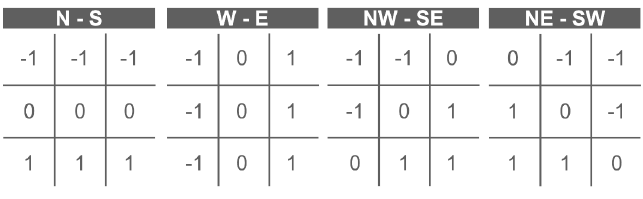
Figure 4. Directional spatial filters applied to Landsat 8 imagery (after [60]).